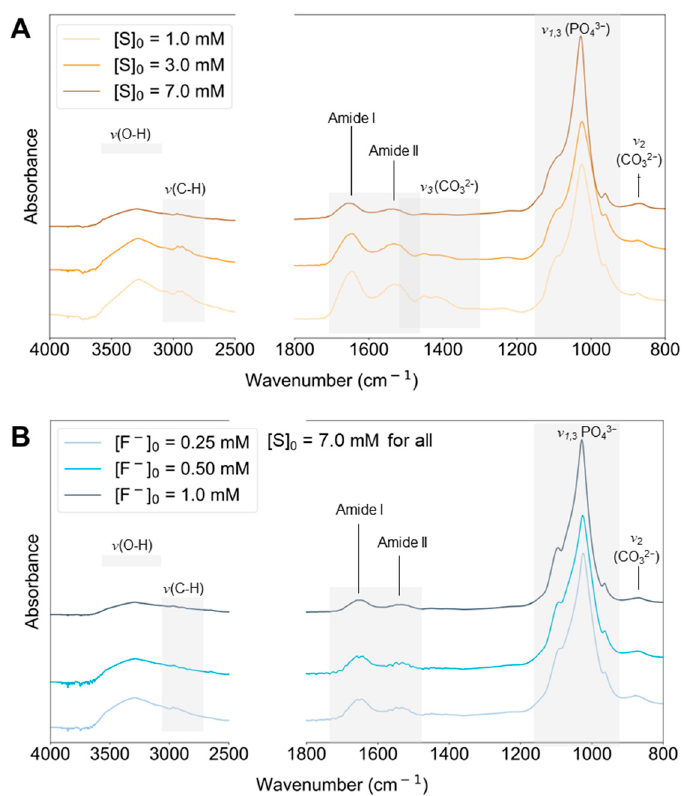
Figure 6. Selected IR-ATR spectra of substituted HAP synthesized by homogeneous enzymatic catalysis ( A ) at variable substrate concentrations, [S] 0 = 1.0, 3.0 and 7.0 mM, or ( B ) at [S] 0 = 7.0 mM and variable fluoride concentrations [F − ] 0 = 0.25, 0.50 and 1.0 mM.